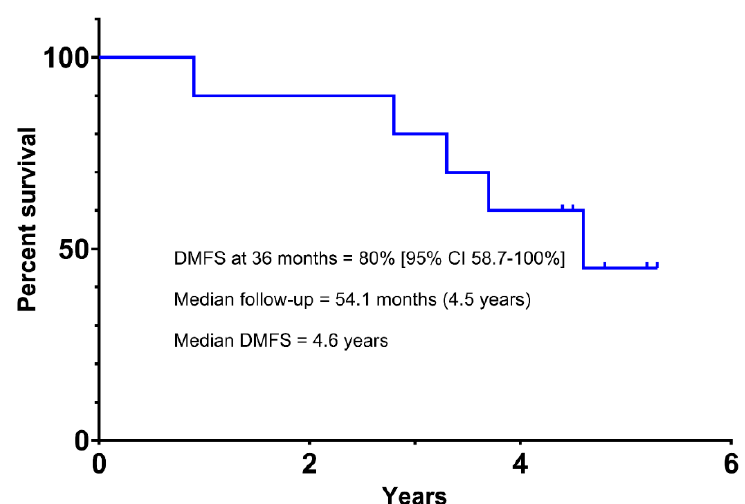
Figure 1. Distant Metastasis-Free Survival (DMFS) in High-Risk Uveal Melanoma Patients Receiving Adjuvant Ipilimumab.